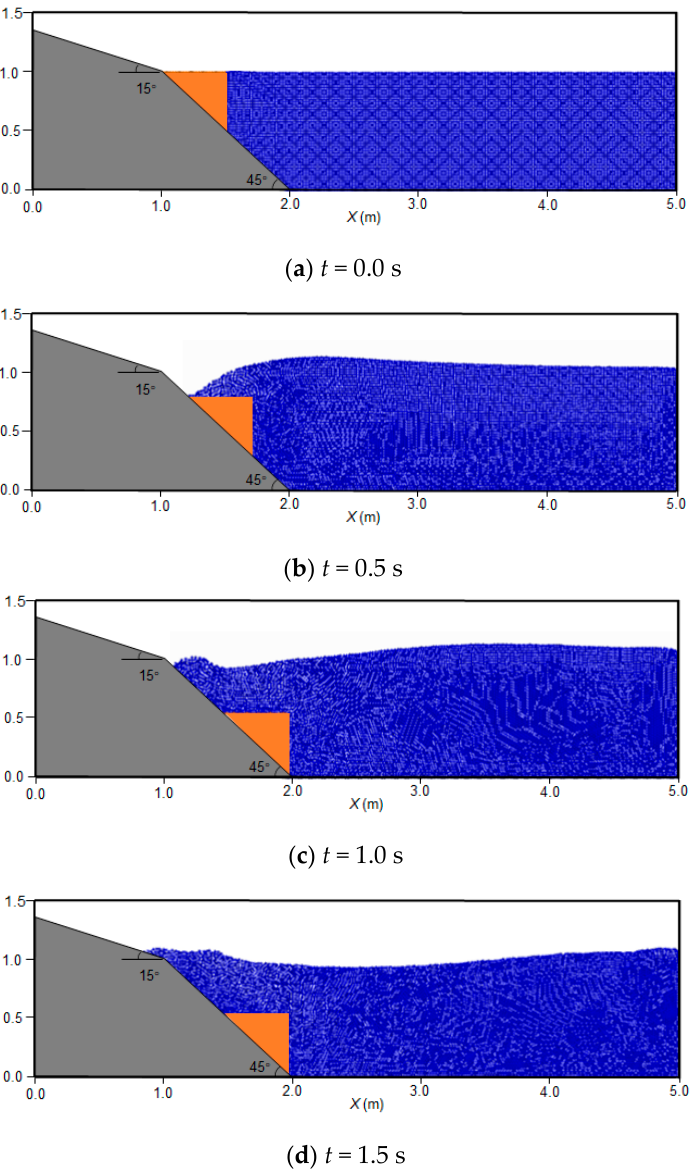
Figure 5. SPH simulated results for the rigid block sliding experiment: ( a ) t = 0.0 s; ( b ) t = 0.5 s; ( c ) t = 1.0 s; ( d ) t = 1.5 s. 1.0 s; ( d ) t = 1.5